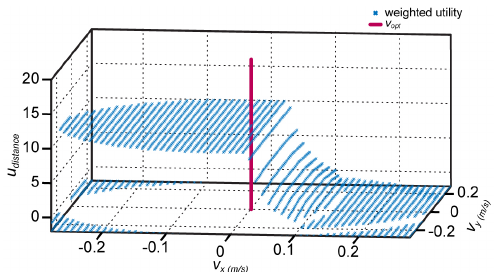
Figure 7. Example of a weighted utility grid for the distance utility of the dynamic window approach. This grid was recorded when the robot faced an obstacle in the x -direction. The utility function drops in the direction of the obstacle as the predicted time until collision decreases. A weighted sum of such grids is used to determine an optimal